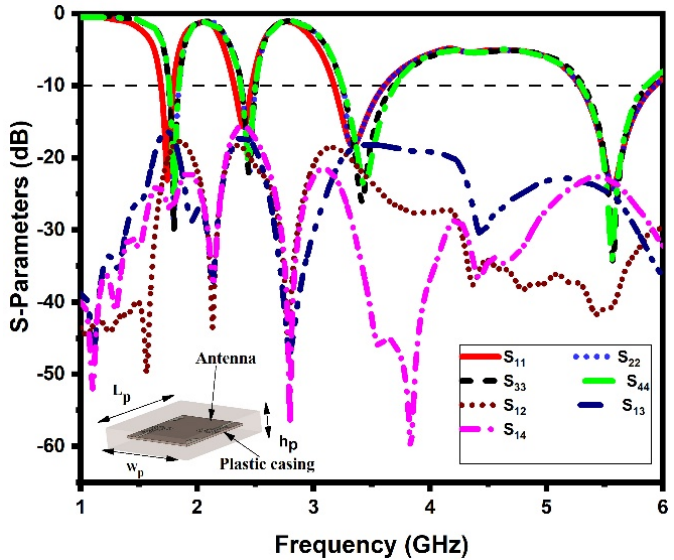
Figure 15. S − parameters inside the plastic casing.